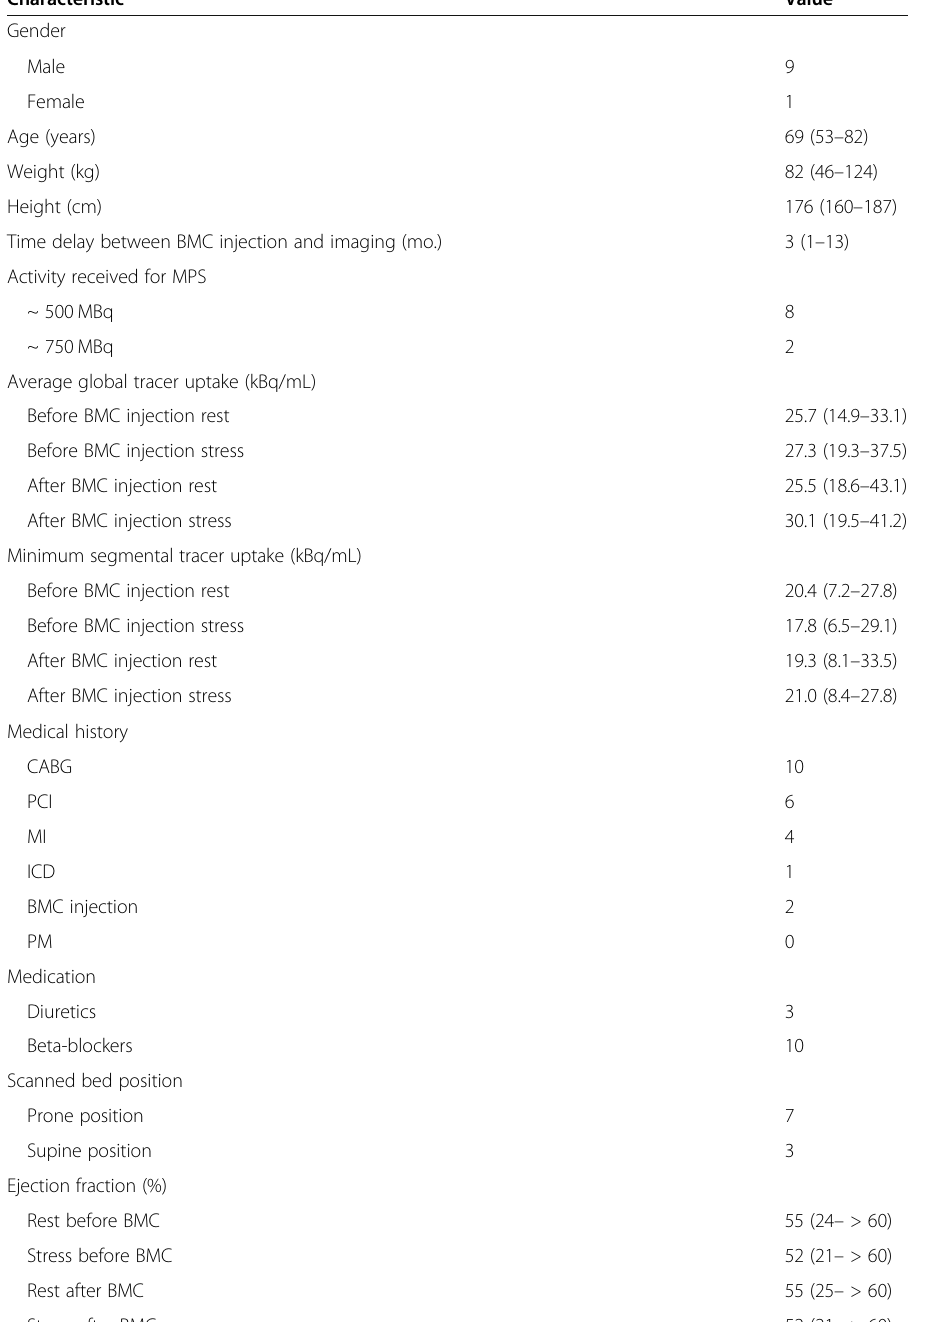
Table 2 Patient characteristics (n =